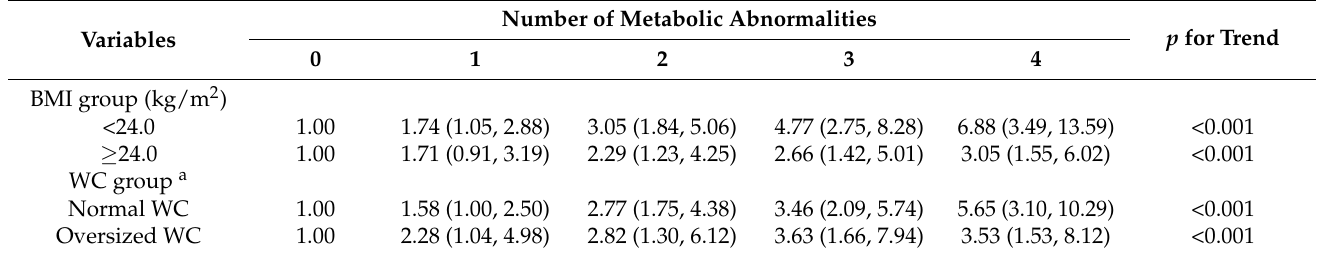
Table 3. Association between the number of metabolic abnormalities and risk of stroke in different BMI and WC